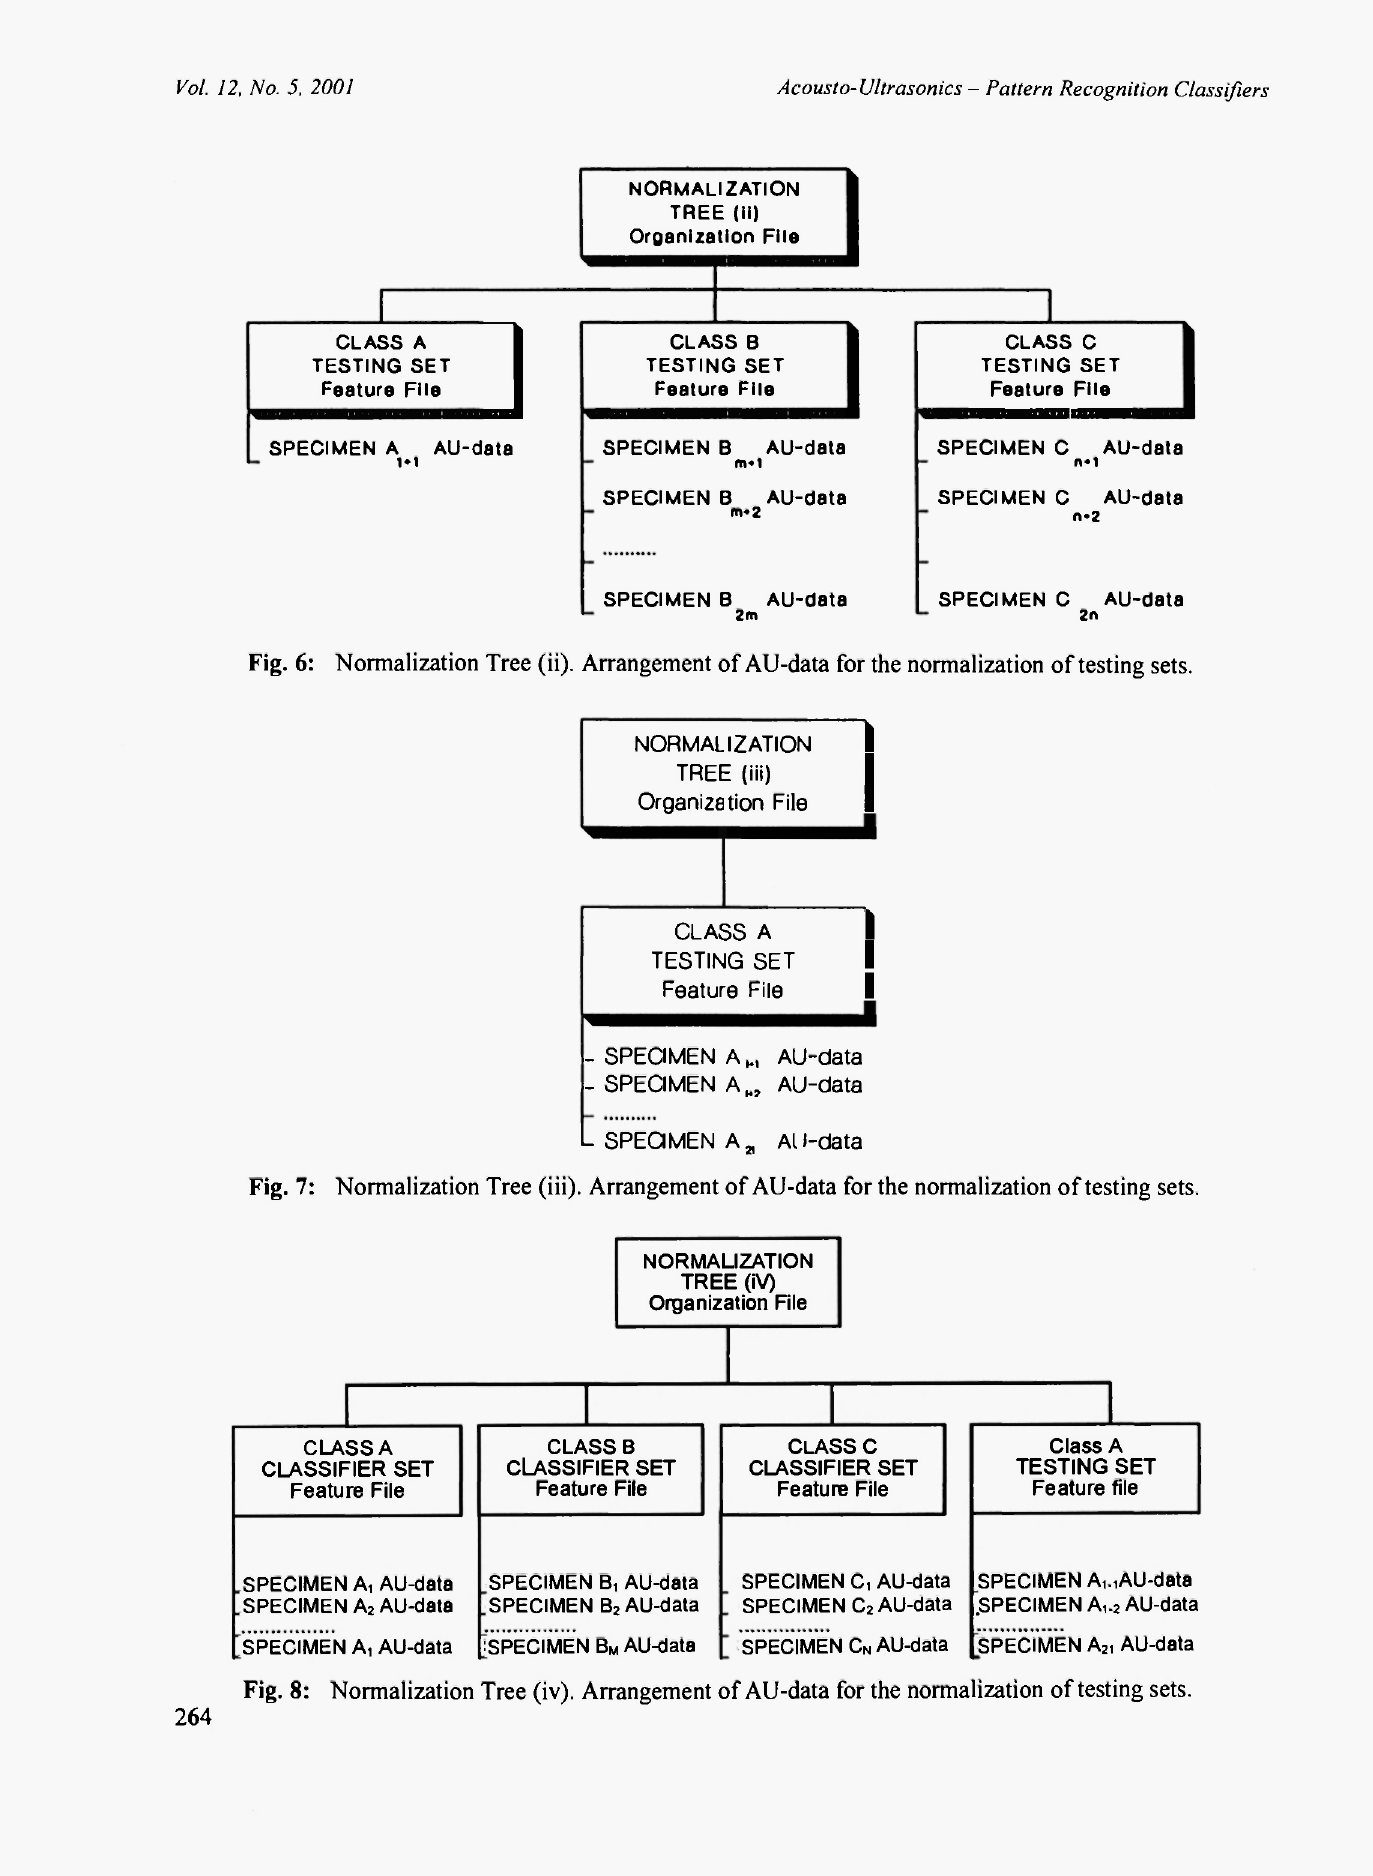
Fig. 6: Normalization Tree (ii). Arrangement of AU-data for the normalization of testing sets.